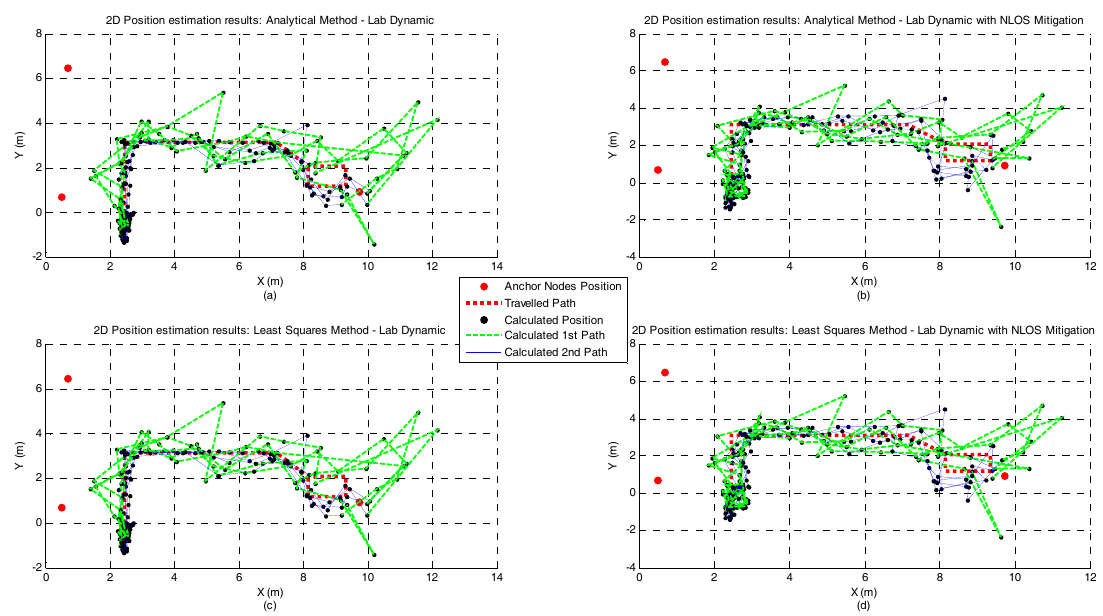
Figure 12. Lab Dynamic test with Analytical ( a , b ) and Least Squares ( c , d ) methods and with and without NLOS identification and mitigation.